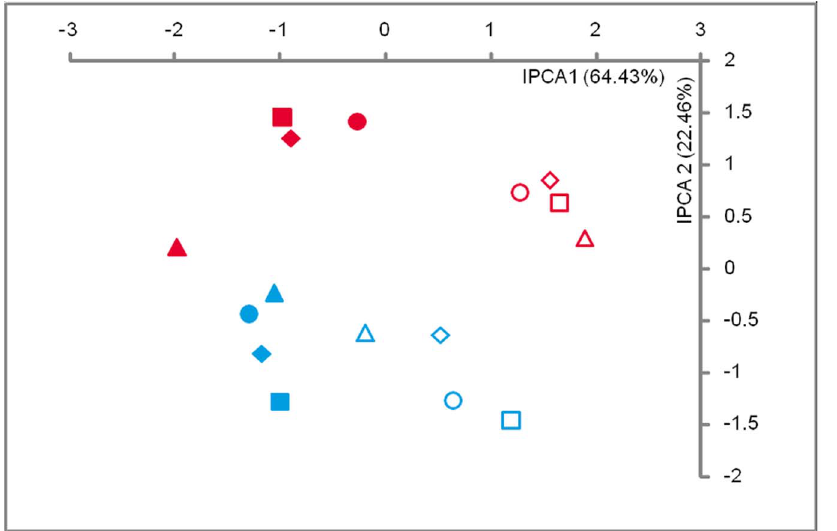
Figure 3. Effect of application mode of Bacillusamyloliquefaciens FZB42 on the rhizosphere bacterial community in the field. N Ordination plot of T-RFLP data analyzed with AMMI showing effect of FZB42 on bacterial community under consideration of the application mode. uninoculated controls; & TTA – two times application 1 week before planting and 4 days after planting; ¤ SA – single application 2 days Symbols: after planting; m TTA2x – two times application with double concentration. Open data points represent plants with natural pathogen pressure of Rhizoctonia solani in the field and closed data points at additional pathogen inoculation of R. solani . Red: Sampling after 2 weeks of growth; Blue: Sampling after 5 weeks of growth.